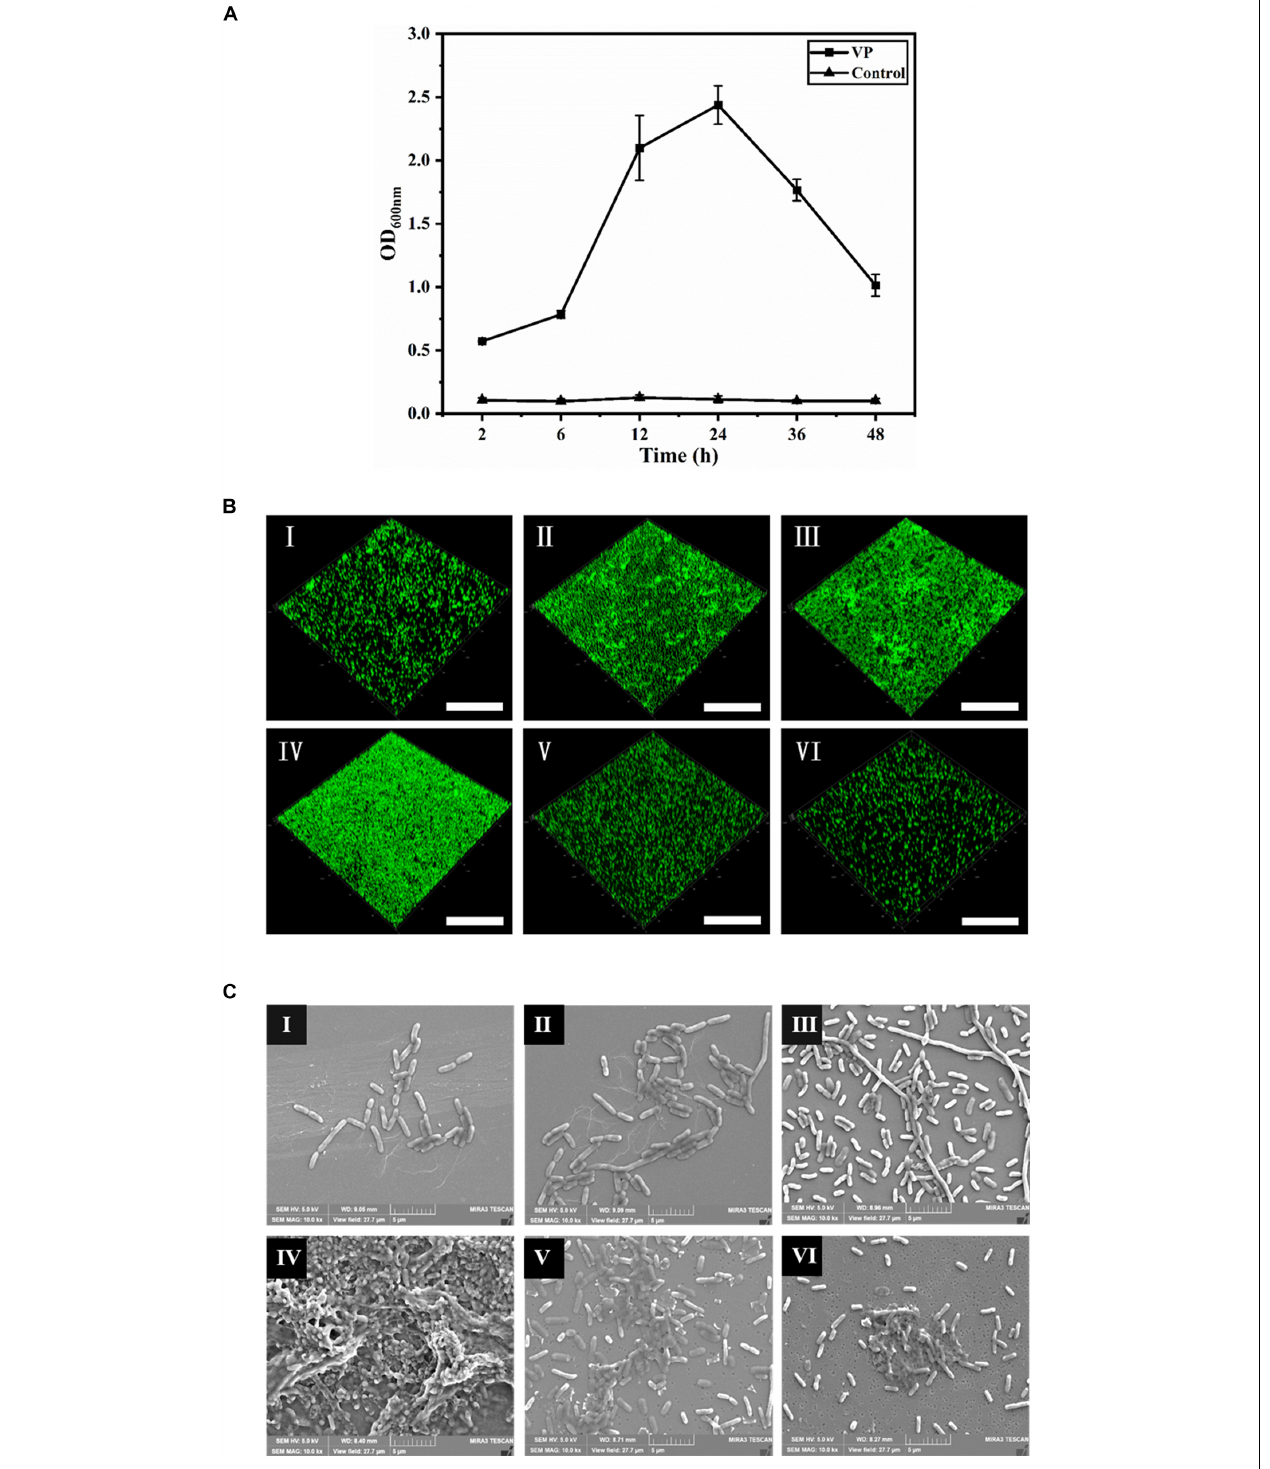
FIGURE 1 | The dynamic process of V. parahaemolyticus biofilm formation. (A) Biofilm biomass was measured by crystal violet binding at an OD 600 after static culture for different times (2, 6, 12, 24, 36, and 48 h). Error bars show standard deviations of three independent experiments. (B) Confocal laser scanning microscopic images of V. parahaemolyticus biofilm development process. The scale bar represents 100 µ m. (C) Scanning electron microscopic images of microstructure during the development of V. parahaemolyticus biofilm. The scale bar represents 5 µ m. I–VI represent 2, 6, 12, 24, 36, and 48 h, respectively. Pictures are representative of three independent experiments with at least three replicates